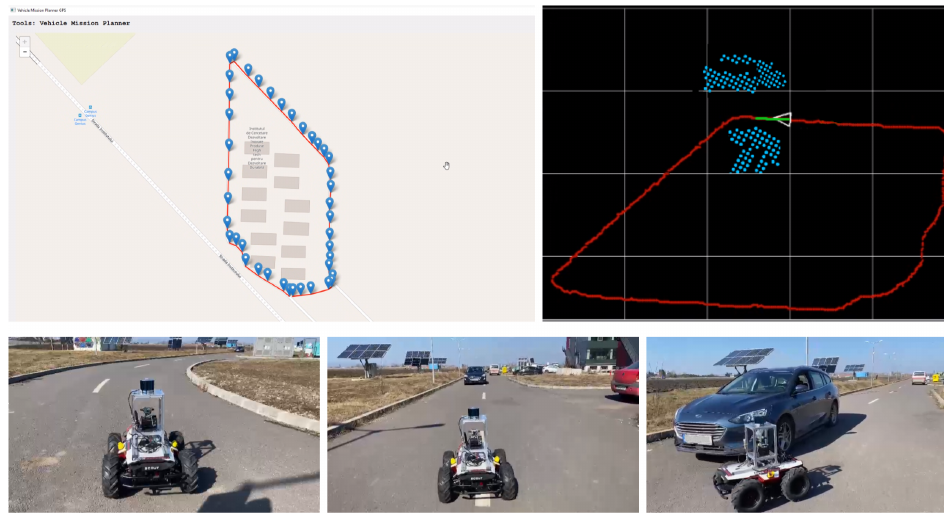
Figure 6. Outdoor testing setup. (top-left) Our vehicle mission planner tool generating the GPS reference route. (top-right) RovisLab AMTU on the reference trajectory with the projected 2D octree environment model. (bottom) On-route behavior with dynamic obstacle